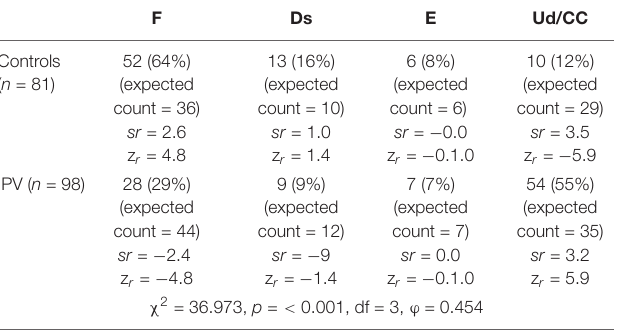
TABLE 2 | AAI classifications in the IPV group and the control group.